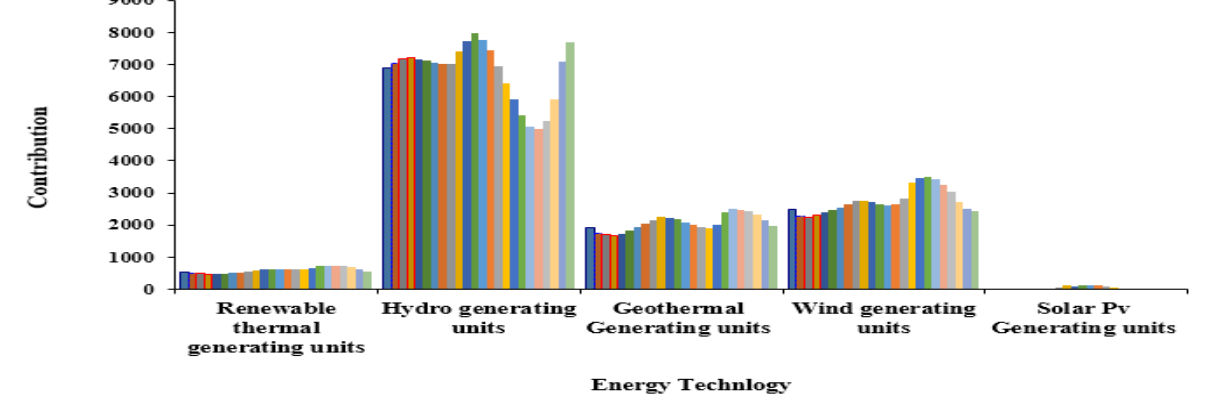
Figure 8. Dispatch value of NREL 118 bus system